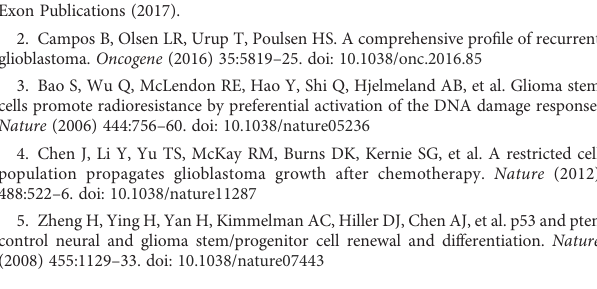
(Figure 1). Studies of the GSC epigenome, epitranscriptome, non- coding RNome and 3D genome architecture can reshape our view of GBM tumor evolution and inform the design of new epigenetic targeting therapies.